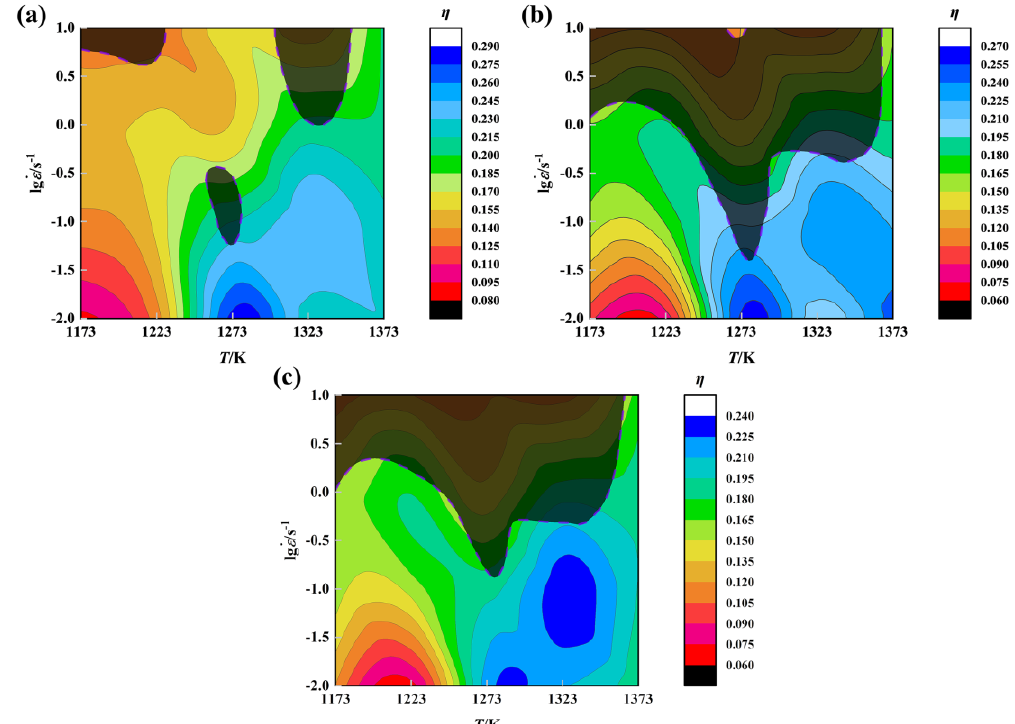
Figure 8. Processing maps at different true strains: ( a ) ε = 0.3; ( b ) ε = 0.6; ( c ) ε = 0.9. The shaded areas are the plastic instability areas, and the colored areas represent the different η values.